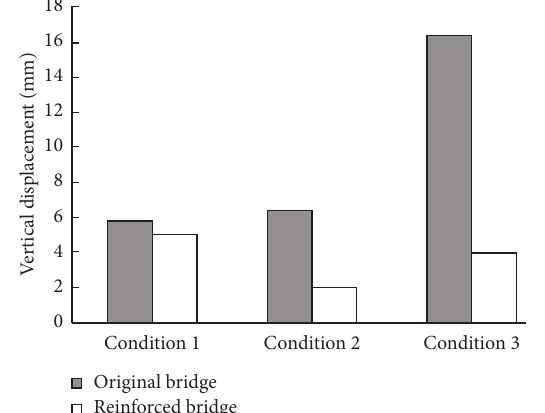
Figure 20: Comparison of peak values of displacement at the mid- span position of bridge deck before and after